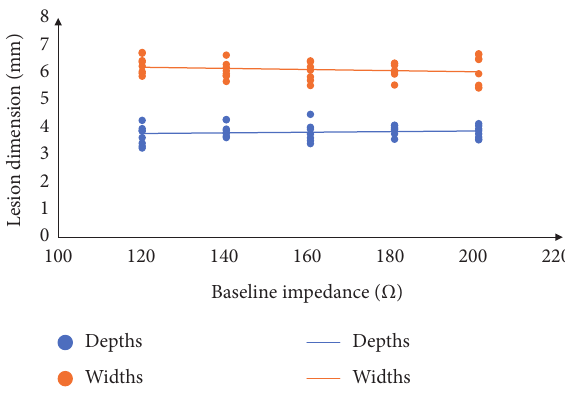
Figure 5: The variation tendency of lesion dimensions in the common AI groups. Table 2: The target AI, actual AI, and damage ranges obtained in different impedance under the guidance of empirical formula. Impedance ( Ω ) Target AI Actual